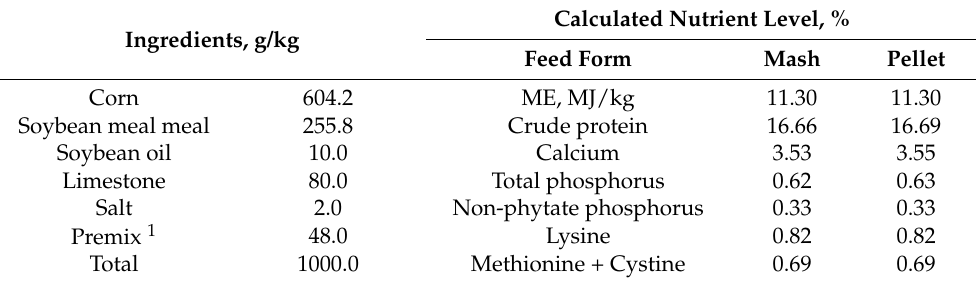
Table 1. Ingredient composition and nutrient levels of the basal diets.